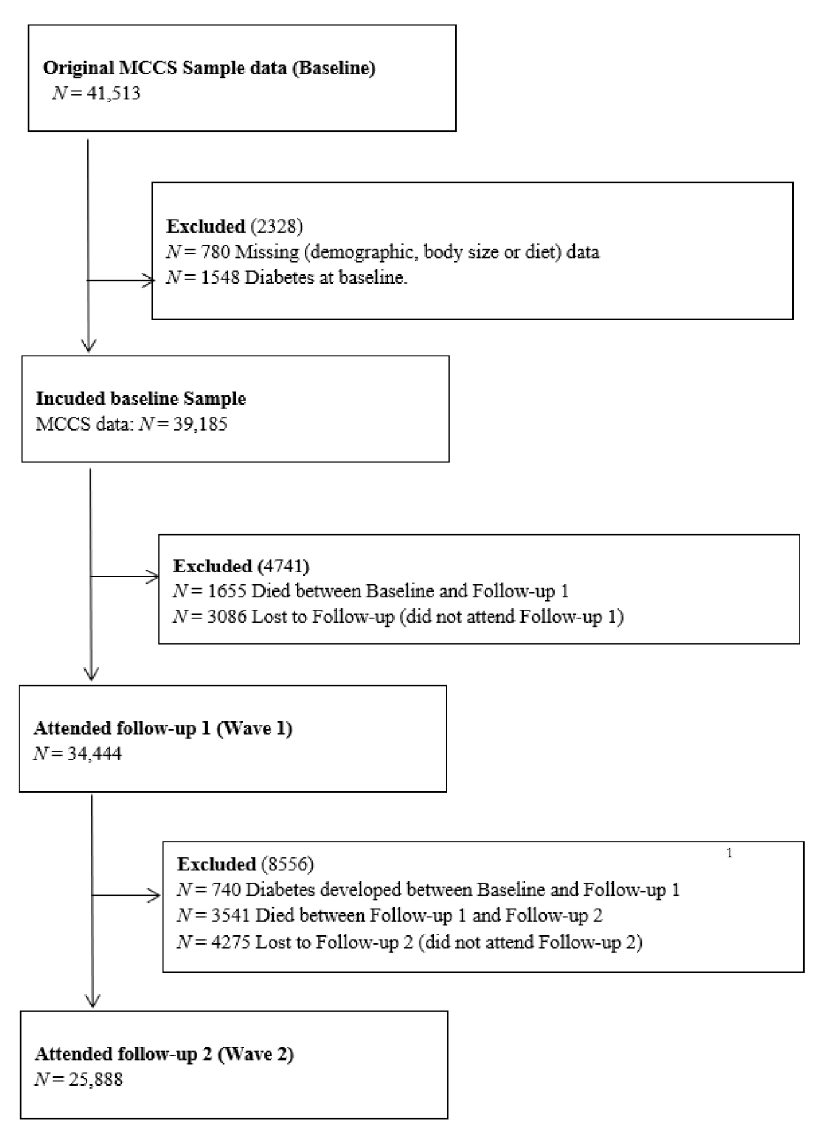
Figure 1. Participant flowchart. 1 People who had already developed diabetes between baseline and follow - up 1 were excluded after follow-up 1 to avoid double